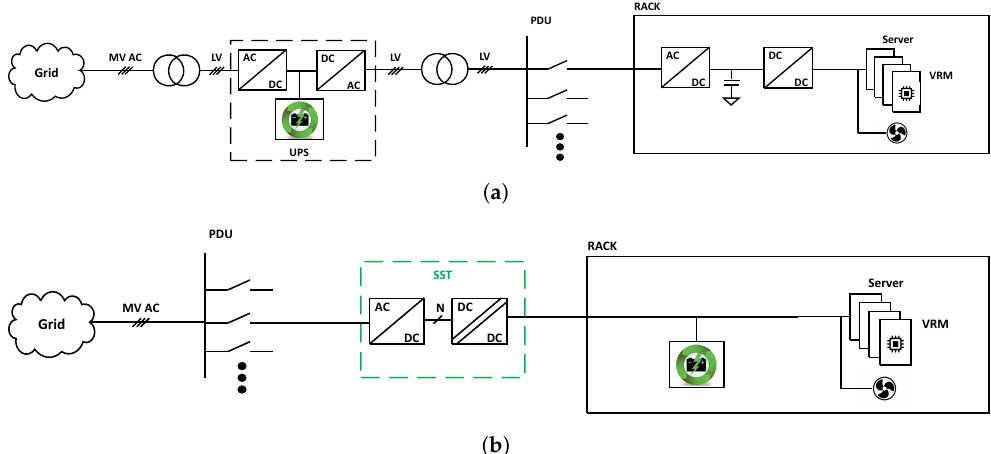
Figure 7. ( a ) Classical approach for a power source supplying a rack in a data centre. Black dots indicate multiple racks connected in parallel. ( b ) The alternative SST